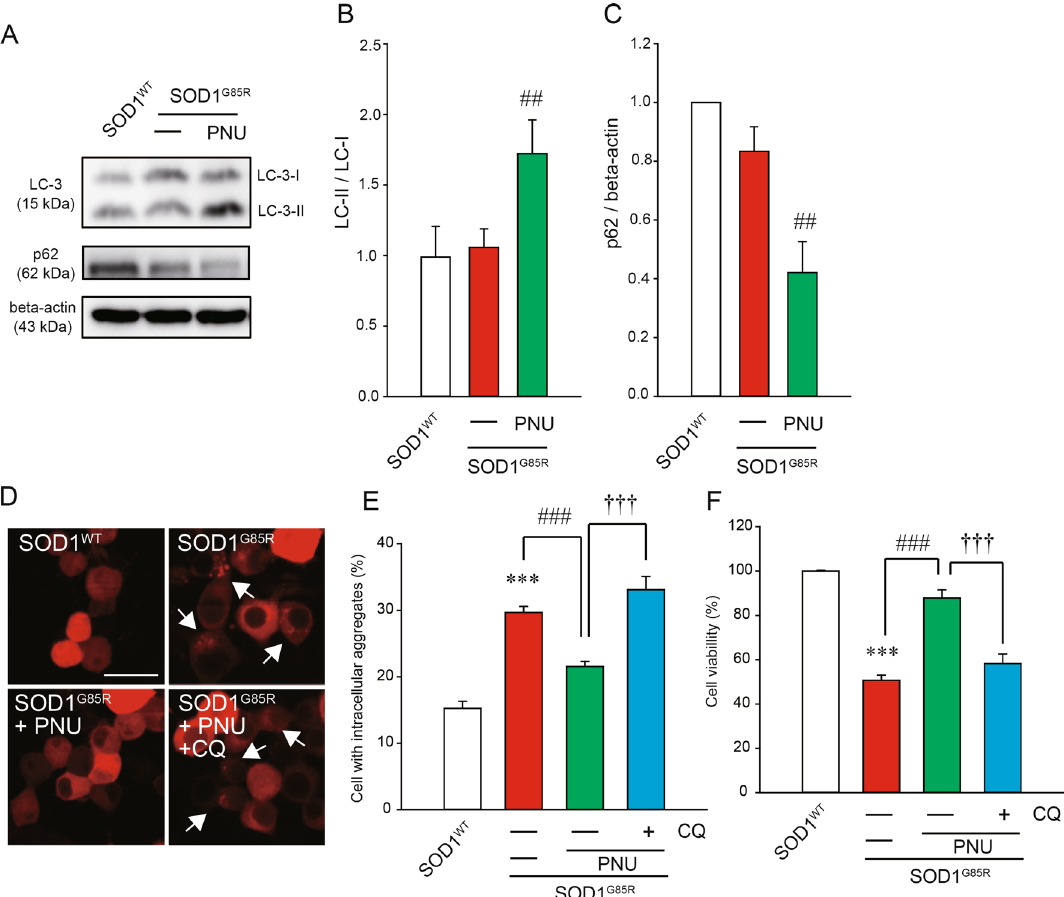
Figure 2. PNU282987 exerted the activation of autophagy. ( A – C ) After 24 h of transfection, N2a cells were transfected with SOD1 G85R , and then incubated with 1 µM PNU282987. The lysates were analyzed by immunoblotting with anti-LC-3 ( A , B ) and p62 ( A , C ) and anti-β-actin antibodies. Levels normalized to the expression of β-actin and quantified based on the band density of SOD1 WT . ( D – F ) N2a cells expressing mCherry-SOD1 G85R were treated with 1 µM PNU282987 (PNU) in the presence or absence of 20 nM chloroquine (CQ) pretreated before 30 min. ( D ) Representative fluorescent microscopy images. Scale bar: 10 µm. ( E ) Quantified data of intracellular SOD1 aggregates. ( F ) The cell viability was measured by MTT assay. Data is expressed as mean ± SEM from three independent experiments. Significance: ### p < 0.001 vs. SOD1 G85R by One-way